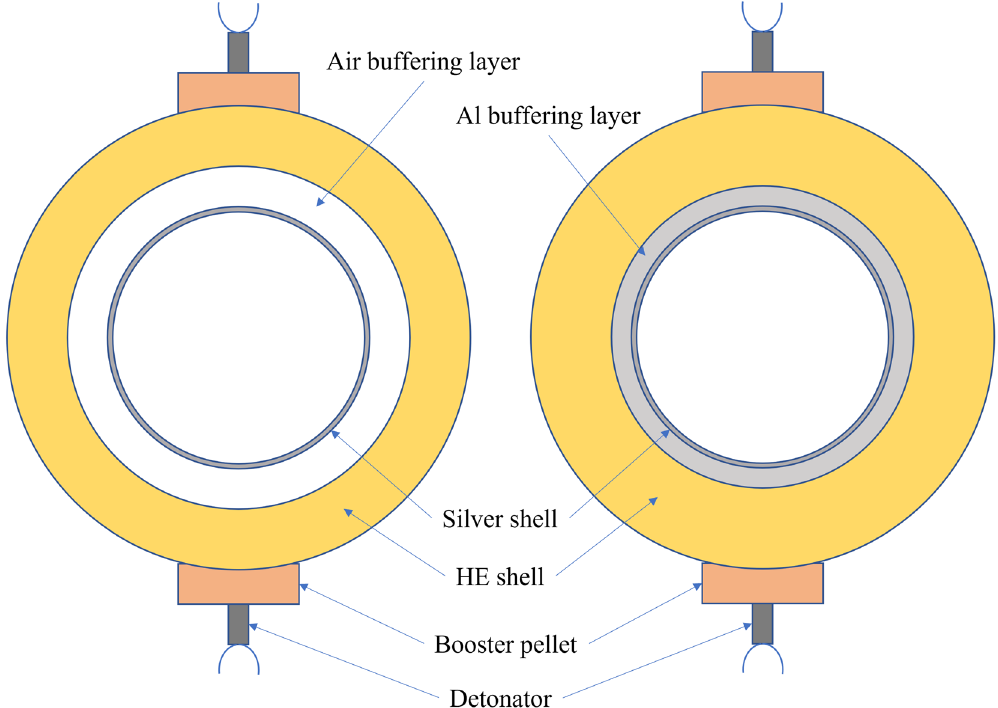
Figure 1. Scheme of HE detonation devices. A silver shell of 1 kg constant mass is located inside a HE (RHT902) shell. A buffering layer of air or aluminum is set between those two shells.